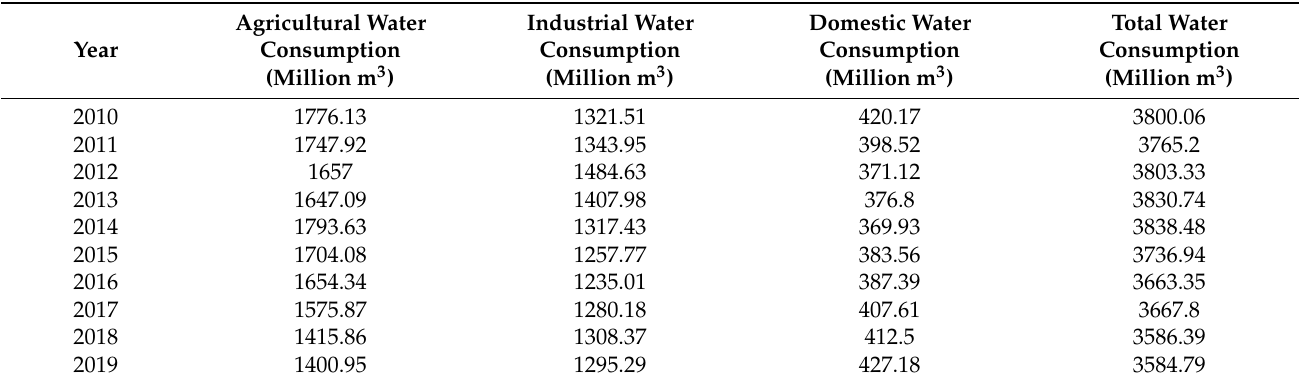
Table 3. Agricultural water consumption, industrial water consumption, domestic water consumption, and total water consumption in Changsha city from 2010 to 2019.